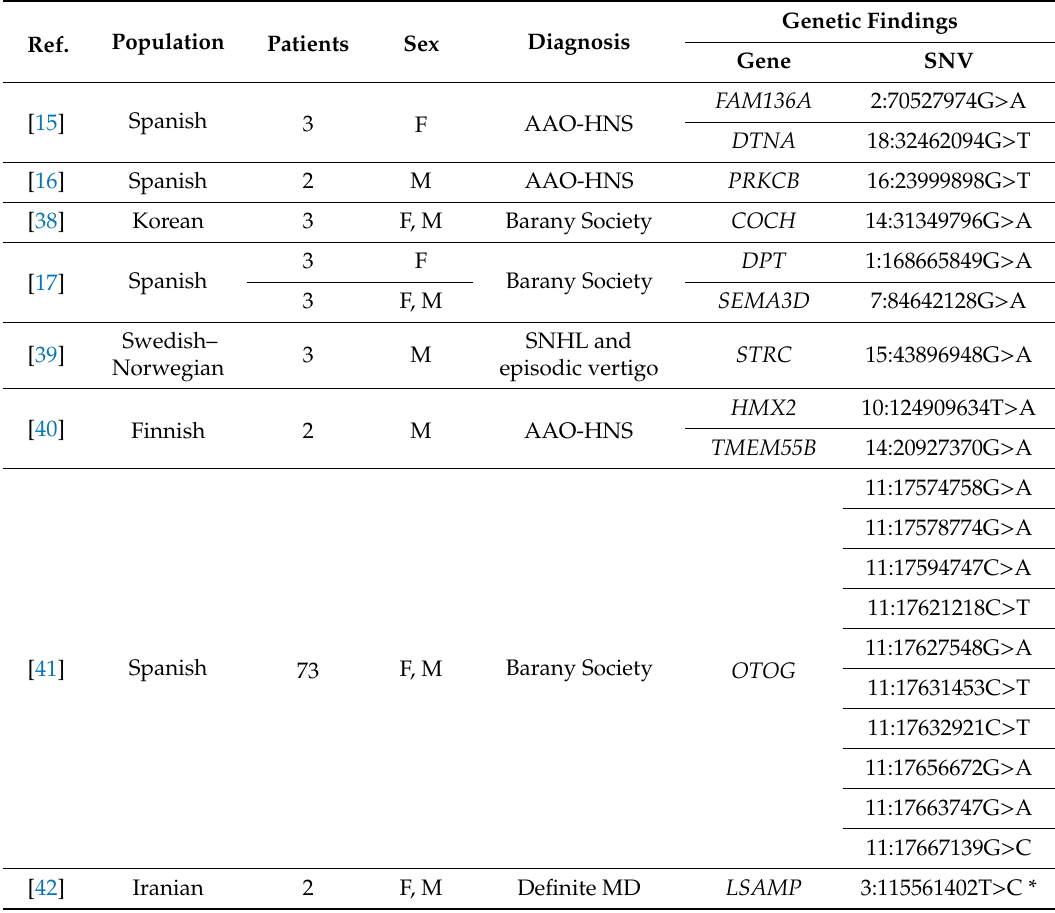
Summary of studies which describe single nucleotide variants (SNVs) selected for quantitative